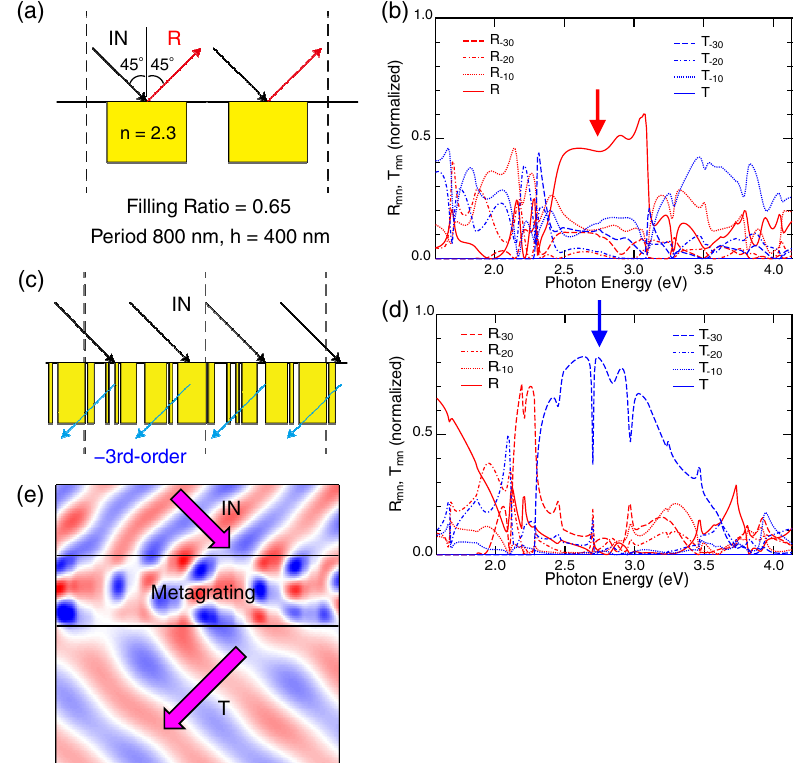
Figure 6. ( a ) A lamella grating of a material with a refractive index of 2.3. The periodic length is 800 nm, the height 400 nm, and the filling ratio in the unit cell 0.65. ( b ) Diffraction components of the lamella grating in ( a ). The incident angle was 45 ◦ . All the open channels are shown; the highest order is the third-order T − 30 and R − 30 . R denotes the zeroth-order reflection, that is ordinary reflection. R m 0 and T m 0 are represented with red and blue curves, respectively. Dotted curves shows the m = 1 component, dot-and-broken curves m = 2, and dashed curves m = 3. ( c ) A high-performance 1D metasurface (metagrating) found in the non-empirical search. The nearest pair of vertical dashed lines indicates the unit cell. ( d ) Diffraction components of the metagrating in ( c ). All the open channels are shown at an incident angle of 45 ◦ . The third-order transmission T − 30 is dominant at 2.5–3.0 eV. The way of curve presentation is in common with that in ( b ). ( e ) A snapshot of the magnetic-field distribution in the metagrating ( c ). The incident light is 2.75 eV, indicated by the blue arrow in ( d ). Effective wave vectors in the incident and transmission layers are drawn with magenta arrows, to guide the eye. The diffraction efficiencies of the lamella grating at incident angle set to 45 ◦ are shown in Figure 6b, where all the open diffraction channels up to the third order are shown. Red curves denote reflective components R m 0 and blue curves transmissive components T m 0 ( m = 1, 2, 3). We note that the zeroth-order components are ordinary reflectance and transmittance, being simply written as R and T, respectively. The largest component is R in the range from 2.5 to 3.0 eV (red solid curve). Note that